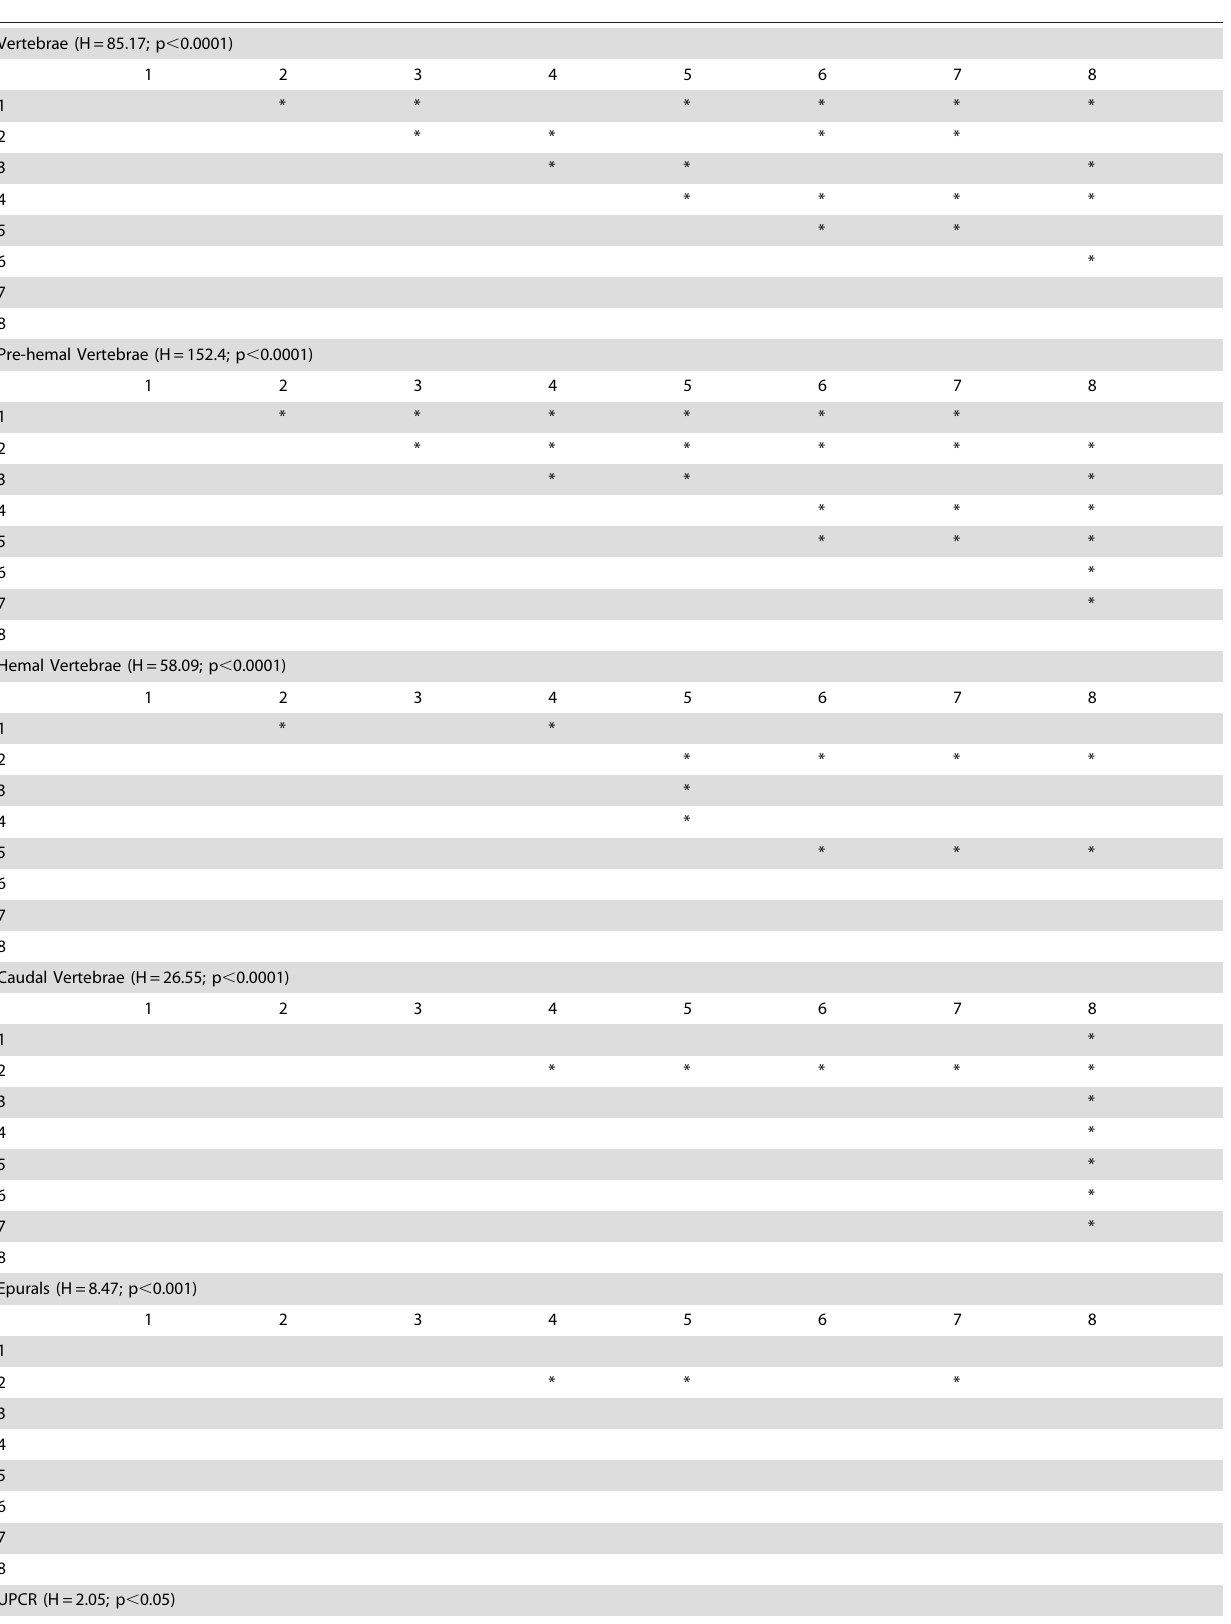
Table 5. Mann-Whitney post-hoc pairwise comparisons (Bonferroni corrected).